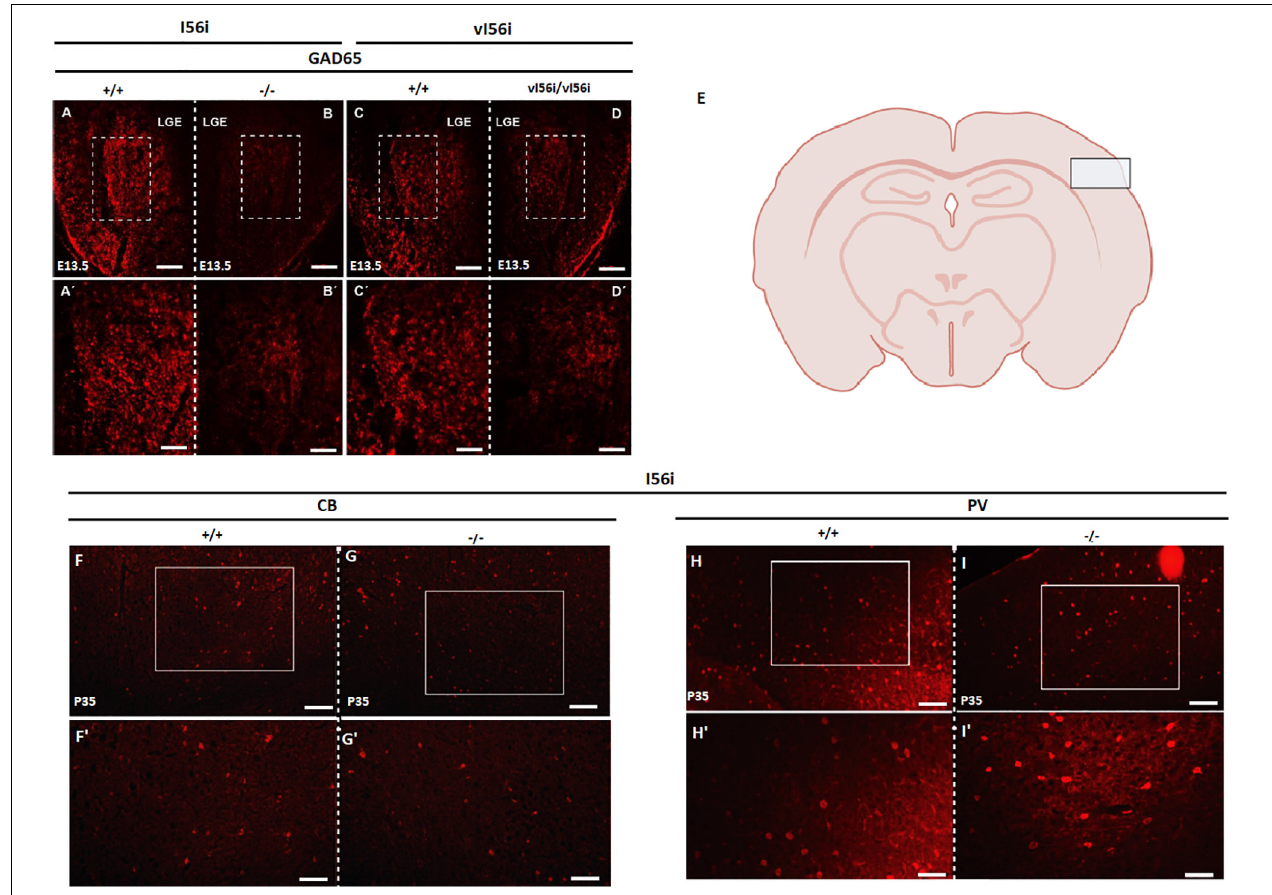
FIGURE 5 | Mutations in the I56i enhancer decreases number of GABA + cells at midgestation. (A–D,A (cid:48) –D (cid:48) ) Immunostaining on E13.5 forebrain tissue with an anti GAD65 antibody. (A,C) WT, (B) homozygous I56i ( − / − ) , and (D) homozygous vI56i. Scale bar (A–D) = 100 µ M and (A (cid:48) –D (cid:48) ) = 50 µ M. (E) schematic drawing of the mouse P35 forebrain, with a box indicating the position of the somatosensory cortex imaged. (F,G,F (cid:48) ,G (cid:48) ) Immunostaining for calbindin using an anti-calbindin antibody on P35 somatosensory cortex. (F) WT and (G) homozygous I56i ( − / − ) . (H,I,H (cid:48) ,I (cid:48) ) Immunostaining for parvalbumin using an anti-parvalbumin antibody on P35 somatosensory cortex. (H) WT and (I) homozygous I56i ( − / − ) . Scale bar (F–I) = 50 µ m and (F (cid:48) –I (cid:48) ) = 25 µ m. LGE, lateral ganglionic eminence; CB, calbindin; PV,